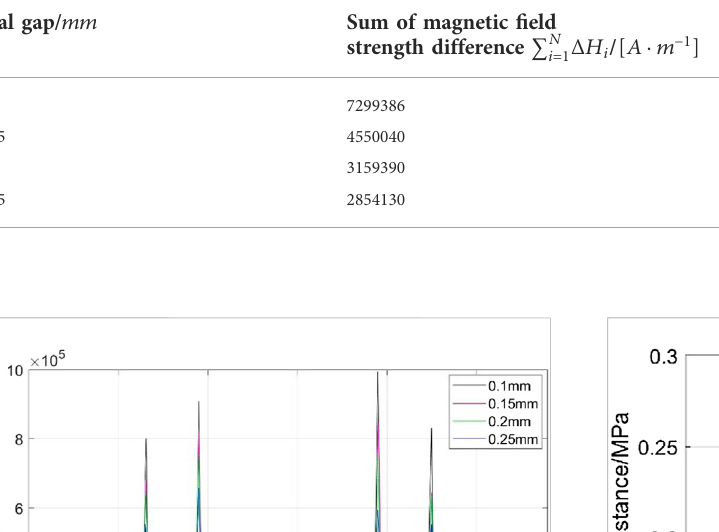
TABLE 2 Relationship between seal gap size and magnetic fi eld strength and pressure resistance.